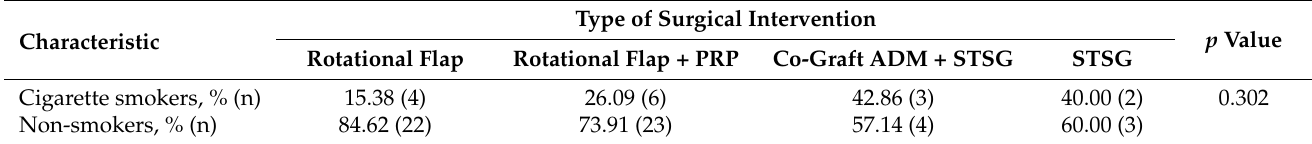
Table 5. Distribution of cigarette smoking with regard to type of surgical